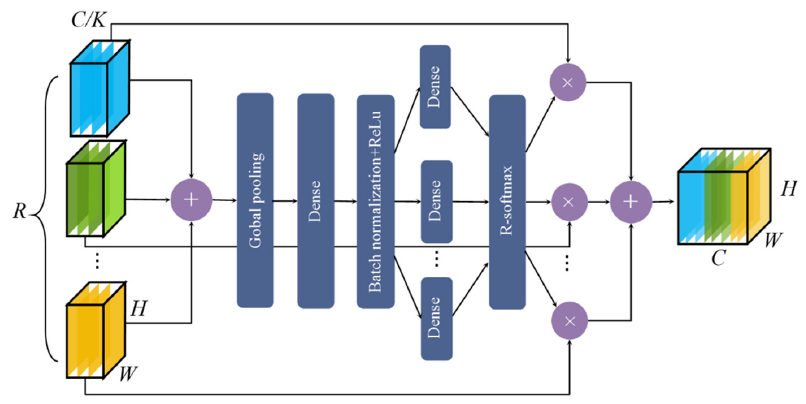
Figure 3. Split-attention module.